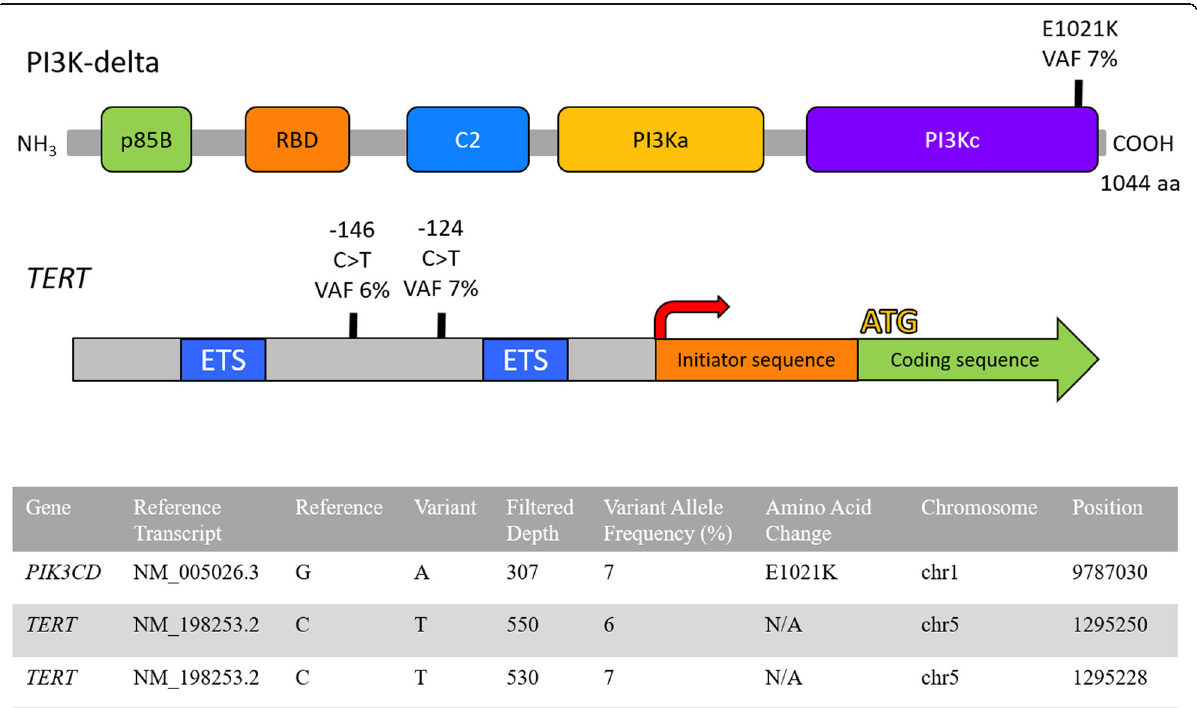
Fig. 5 Candidate mutations in patient 1. Top: Structure of PI3K-delta protein with functional domains and point mutation at position 1021 located in the catalytic domain. p85B = p85 binding domain, RBD = ras binding domain, C2 = C2 domain present in class I beta and delta PI3Ks, PI3Ka = accessory domain, PI3Kc = catalytic domain. Middle: Structure of TERT gene and upstream regulatory region showing two point mutations identified in the TERT promoter. Red arrow = transcription start site, ATG = coding sequence start site, ETS = ETS family transcription factor binding sites. Bottom: Candidate pathogenic mutations identified via targeted sequencing analysis of case 1 biopsy specimen by Heme-STAMP . Filtered depth = read depth of the variant